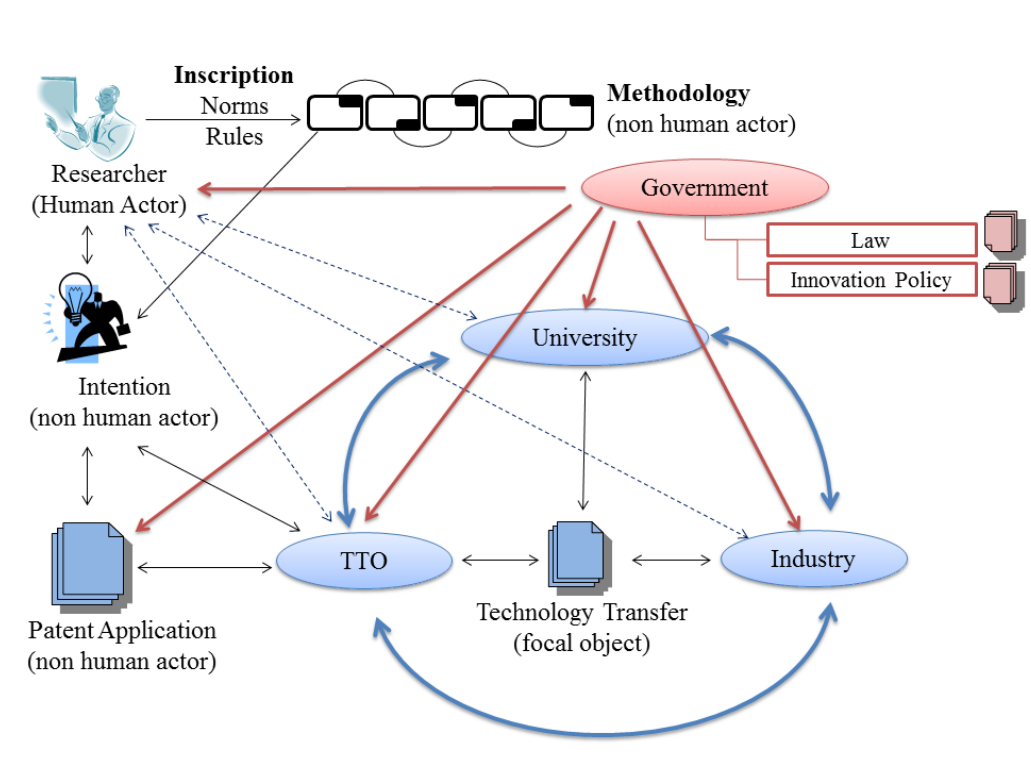
Fig. 2. Summary of the analytical